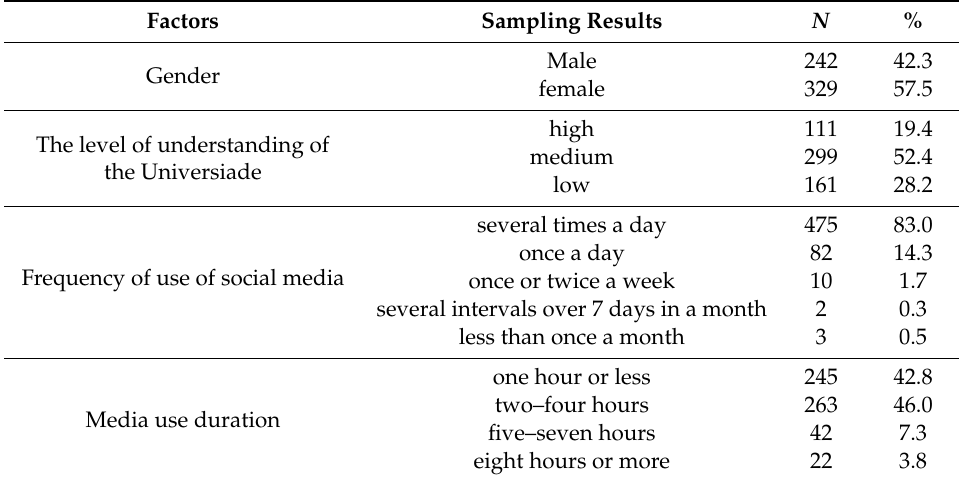
Table 1. Descriptive statistics of respondent background